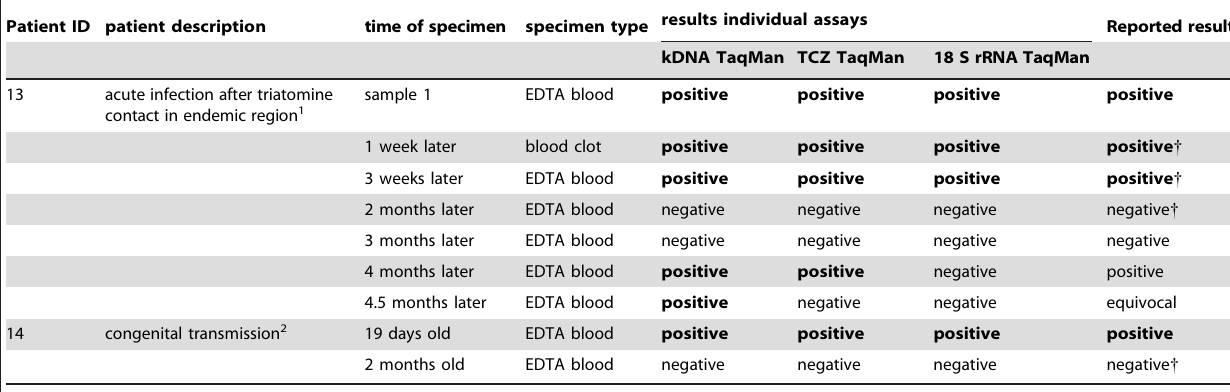
Table 5. Detailed PCR findings for patients with acute Chagas disease.